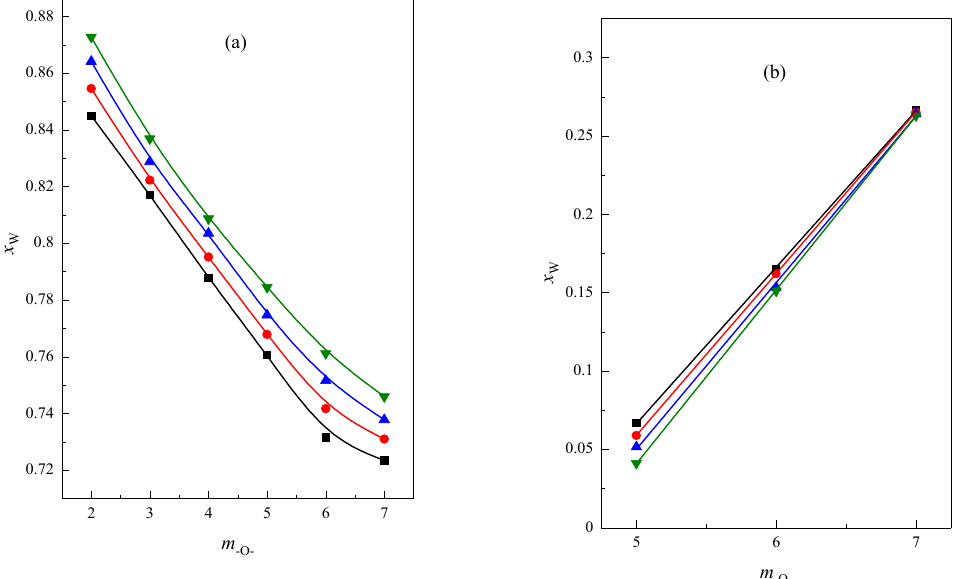
Figure 5. The location ( x W ) of the first ( a ) and second ( b ) intersection point of the isomolal functions κ S = f ( x W ) derived for glyme solutions in the DMF + W mixed solvent as a function of the number of oxygen atoms in the glyme molecule ( m –O– ) at the temperatures of ■ 293.15 K, ● 298.15 K, ▲ 303.15 K, ▼ 308.15 K.